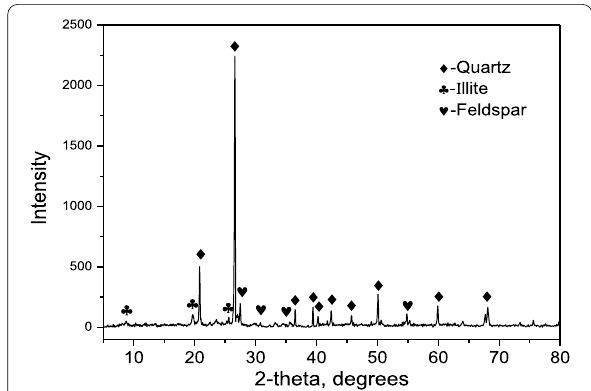
Fig. 2 XRD of calcined